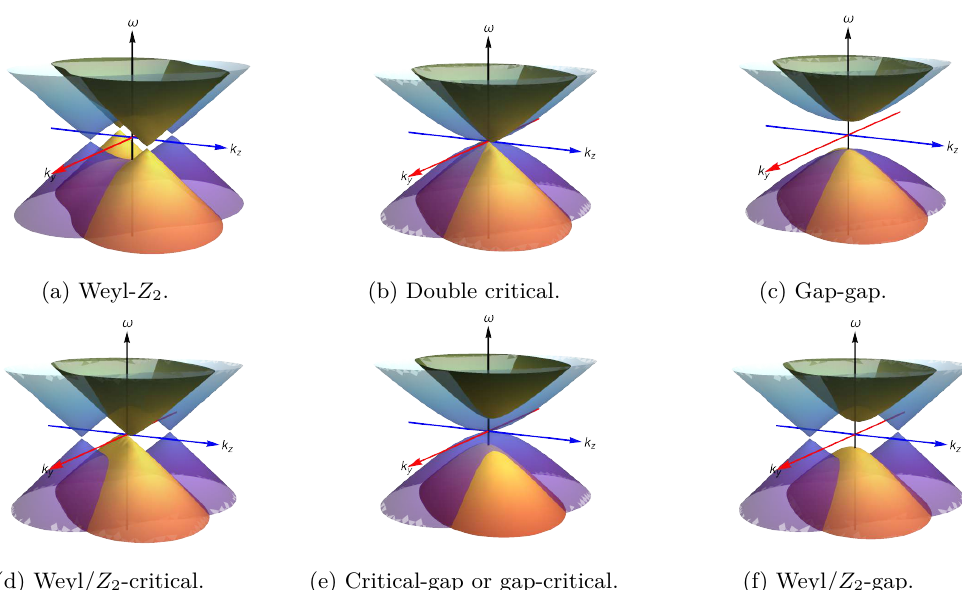
Figure 1. The energy spectrum of (2.5) as a function of k y and k z with k x = 0 . From (a) to (f): the system has two pairs of Weyl/ Z 2 nodes (a), two critical Dirac nodes (b), fully gapped (c), one pair of Weyl/ Z 2 nodes and a critical Dirac node (d), a critical Dirac node and a gapped phase (e) and the case of one pair of Weyl/ Z 2 nodes with two gapped bands (f). Note that at nonzero k x the system is gapped, thus the crossing nodes are still nodes in the three dimensional momentum space. into a pair of gapped bands and one twofold-degenerate critical point. These two phases correspond to two phase transition lines between the gap-gap phase and the Weyl/ Z phase. This spectrum is shown in (e) of figure